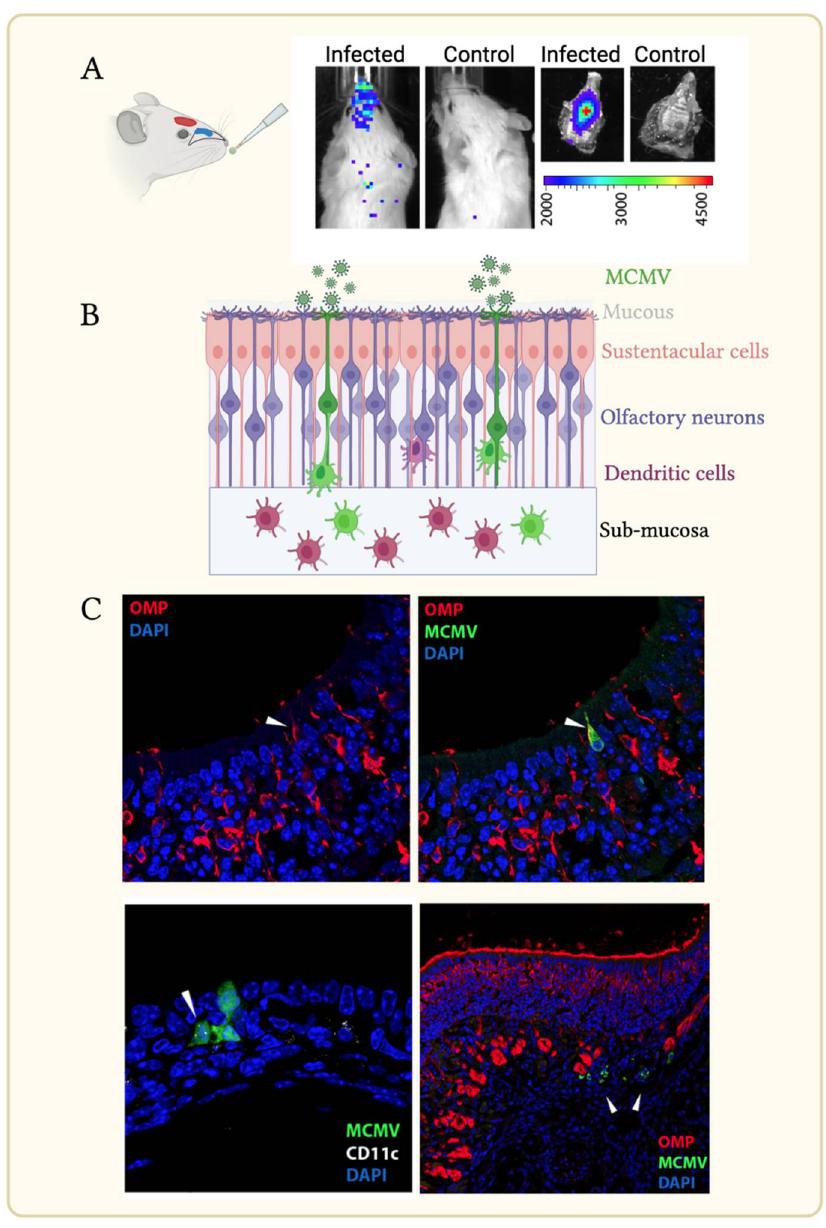
Figure 1. The olfactory epithelium is a site of MCMV entry. ( A ) Alert mice inoculated with <5 uL of inoculum to the nares. The olfactory epithelium (blue) lines the nasal turbinate protruding into the nasal cavity. Axons of olfactory neurons link to the olfactory bulb (red) which is positioned anterior to the brain. Nose infection detected by live imaging 3 days post-infection with a luciferase-tagged MCMV ( left ) compared with an uninfected control mouse ( right ); dissection of the palate reveals localized luciferase expression in infected animals. The light intensity scale (p/s/cm 2 /sr) is shown. ( B ) Simplified schematic of olfactory infection. Olfactory neurons, whose dendrites contact the environment above the mucous layer are the first targets for MCMV. Infection passes to sustentacular cells and dendritic cells (DC). Infected DC mobilize to the submucosa. ( C ) Immunohistochemical detection of infected of OMP + olfactory neurons (upper panel, arrow) 24 h following infection with an EGFP-tagged MCMV; infection of an adjacent CD11c + cell detected day 3 p.i. (lower panel left; arrow); by day 4 p.i. numerous infected cells presumed to be DC based on further staining (arrowed) were detected in the sub-mucosa (lower panel,